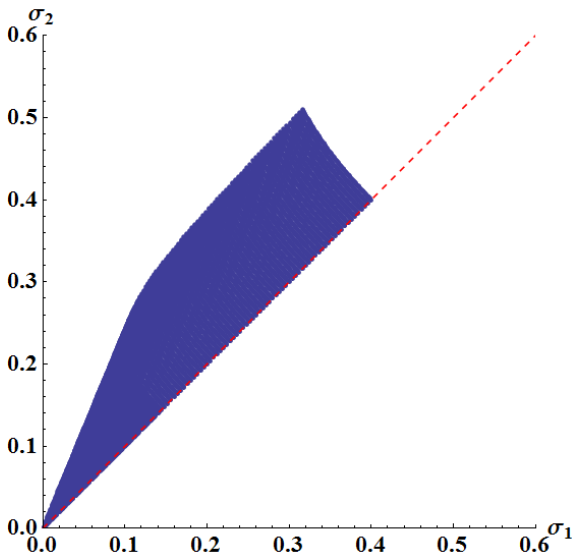
Figure 5 . The gauge coupling dependence of (cid:27) 1 and (cid:27) 2 in the case (II), which is given by eqs. (5.27), (5.31), and (5.32). We change the gauge couplings, (cid:2) 1